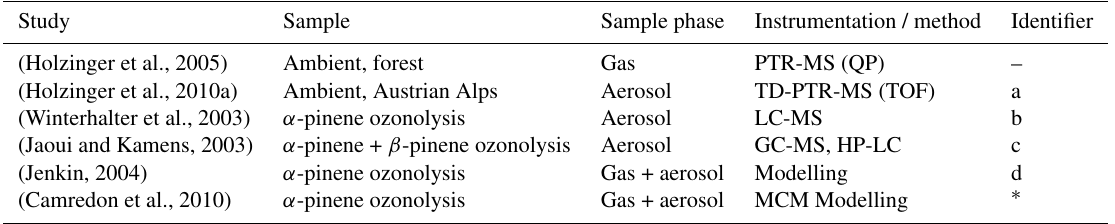
Figure 3. Mass concentration thermograms of compounds desorbing from filter C1f as detected by PTR-MS. Filter C1f contains SOA from α -pinene ozonolysis in dark and dry conditions using cyclohexane as an OH scavenger. All ions are labelled by their masses in daltons (Da) and their identified molecular formula. Ions with the largest concentrations are listed first. The 10 ions with highest mass concentrations are plotted in (a) . The most abundant ions found in this study with masses similar to compounds reported in the literature (see Table 3) are plotted in (b) . These are the same compounds as those below the line in Table 4 and include those predicted by the MCM, e.g. pinic acid (187.093Da) and pinonic acid (185.117Da). See Sect. S4 for more details. Most ions show a peak at 150 ◦ C, but their desorption patterns differ at lower and higher temperatures. Table 3. Main references cited in this study for comparison of chemical composition. The identifier (last column) denotes the letter the reference corresponds to in Table 4 and Sect. S6. Abbreviations: QP: quadrupole; TD: thermal desorption; TOF: time-of-flight; LC: liquid chromatography; MS: mass spectrometer; GC: gas chromatography; HP: high